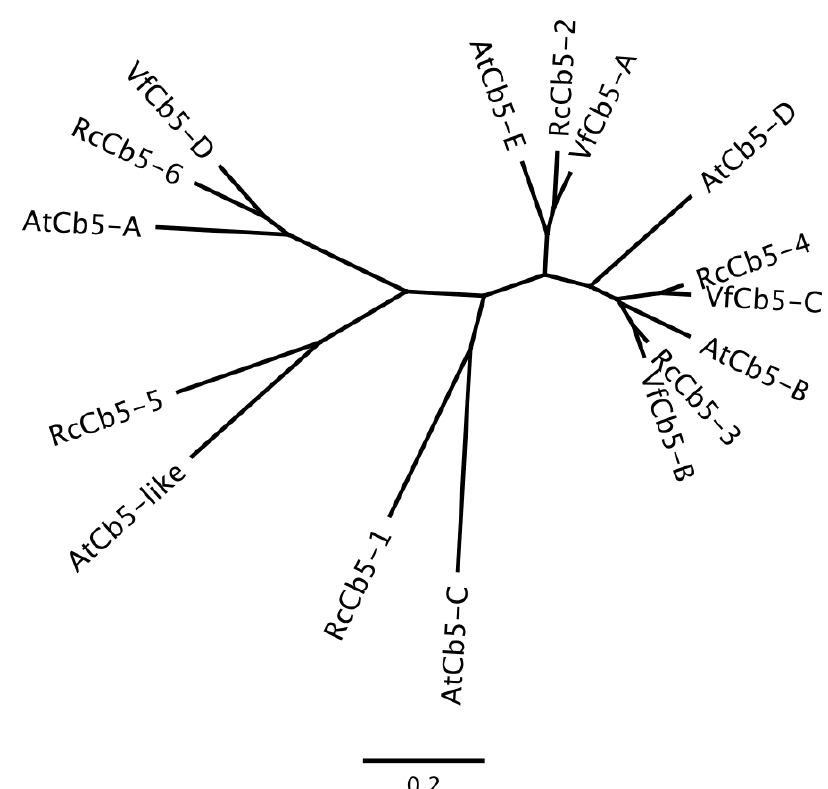
Figure 1. Phylogenetic relationships among 16 Cb5 proteins. Protein sequences from Arabidopsis thaliana (At), Ricinus communis (Rc), and Vernicia fordii (Vf) were used to build an unrooted dendrogram in Geneious v5.1 (www.geneious.com). Size bar indicates genetic distance between proteins using the Neighbor-Joining method.